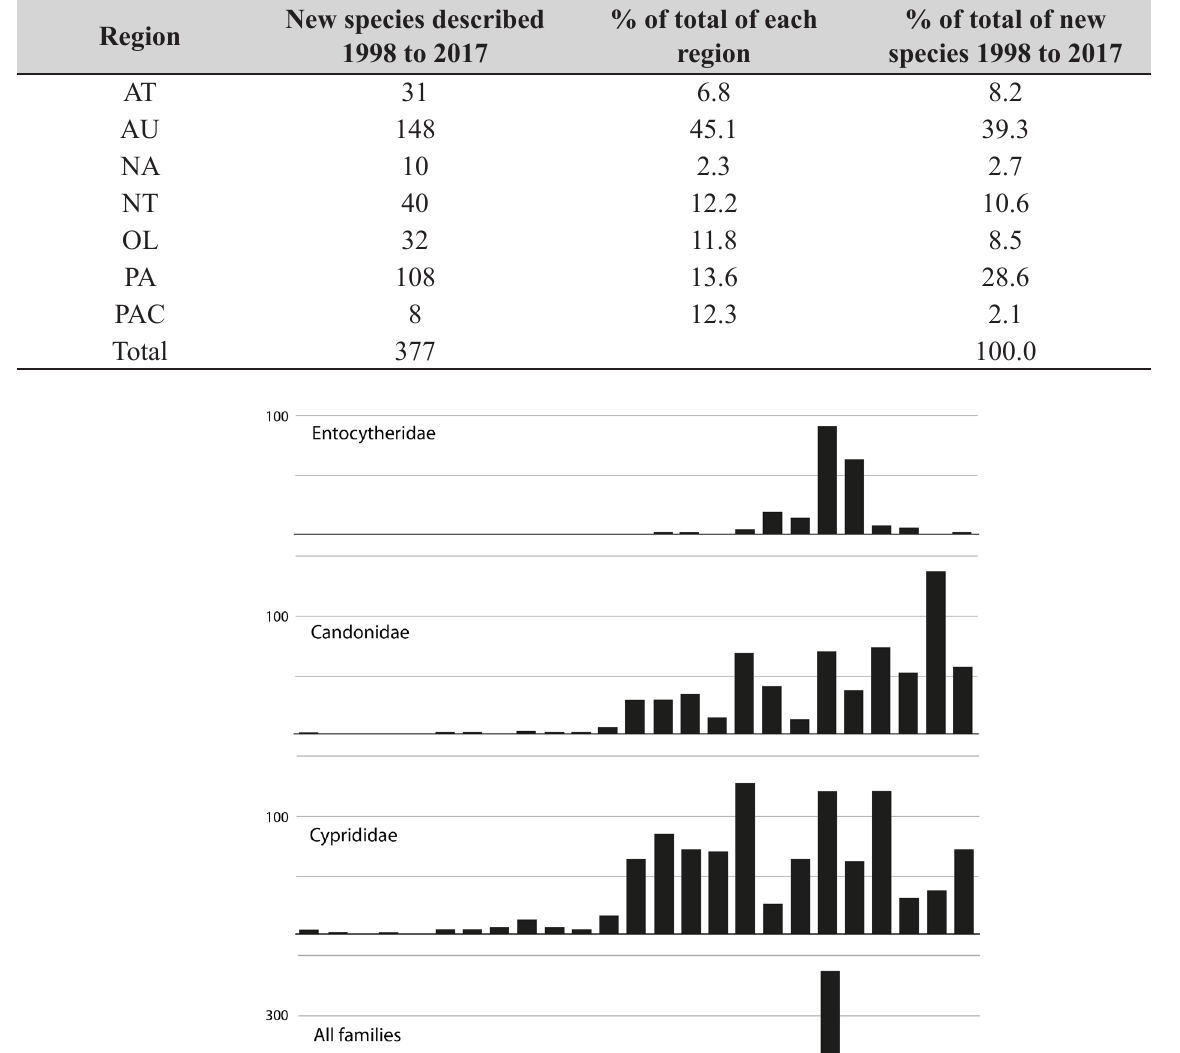
Table 3. Numbers of new species described in the 20-year period between 1998 and 2017 in the different zoogeographical